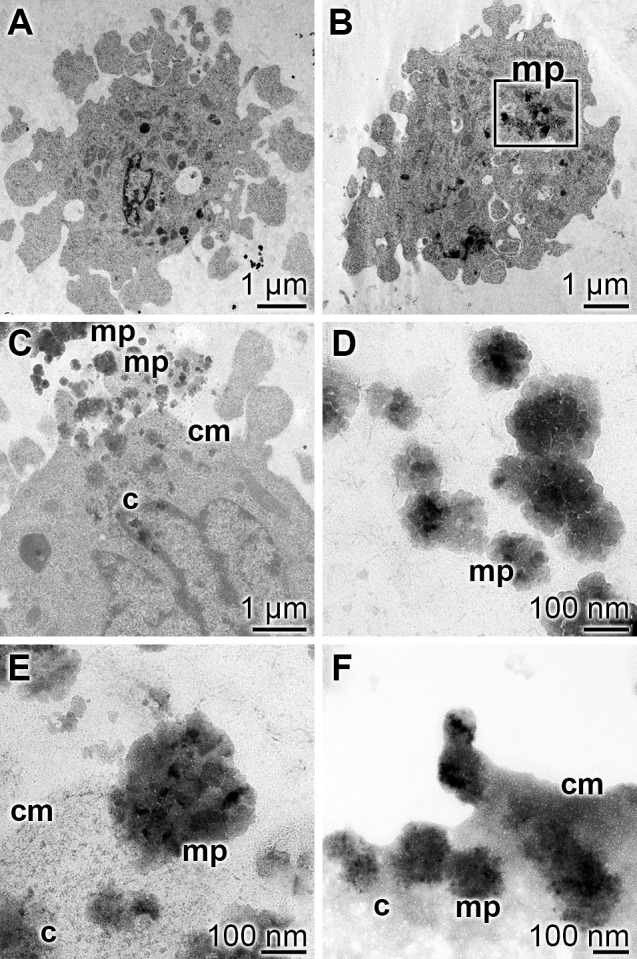
Uptake of microparticles (“Ca-polyP-MP”) by SaOS-2 cells; TEM.The cells were incubated with 30 μg/mL of “Ca-polyP-MP” or remained untreated (controls) for 3 d and then were processed for TEM analysis. The microparticles (mp) can be distinguished from cell constituents by their electron-dense appearance. (A) In the control cells no distinct electron-dense particles can be distinguished. (B to F) In contrast, cells exposed to “Ca-polyP-MP” show abundantly the electron-dense particles; in (B) an area filled with microparticles is highlighted by a square. (C, D) The extracellular applied microparticles associate with the cell membrane (cm) and (E) become internalized into the cell (c). (F) Especially near the cell membrane the particles remain in a distinct shape.